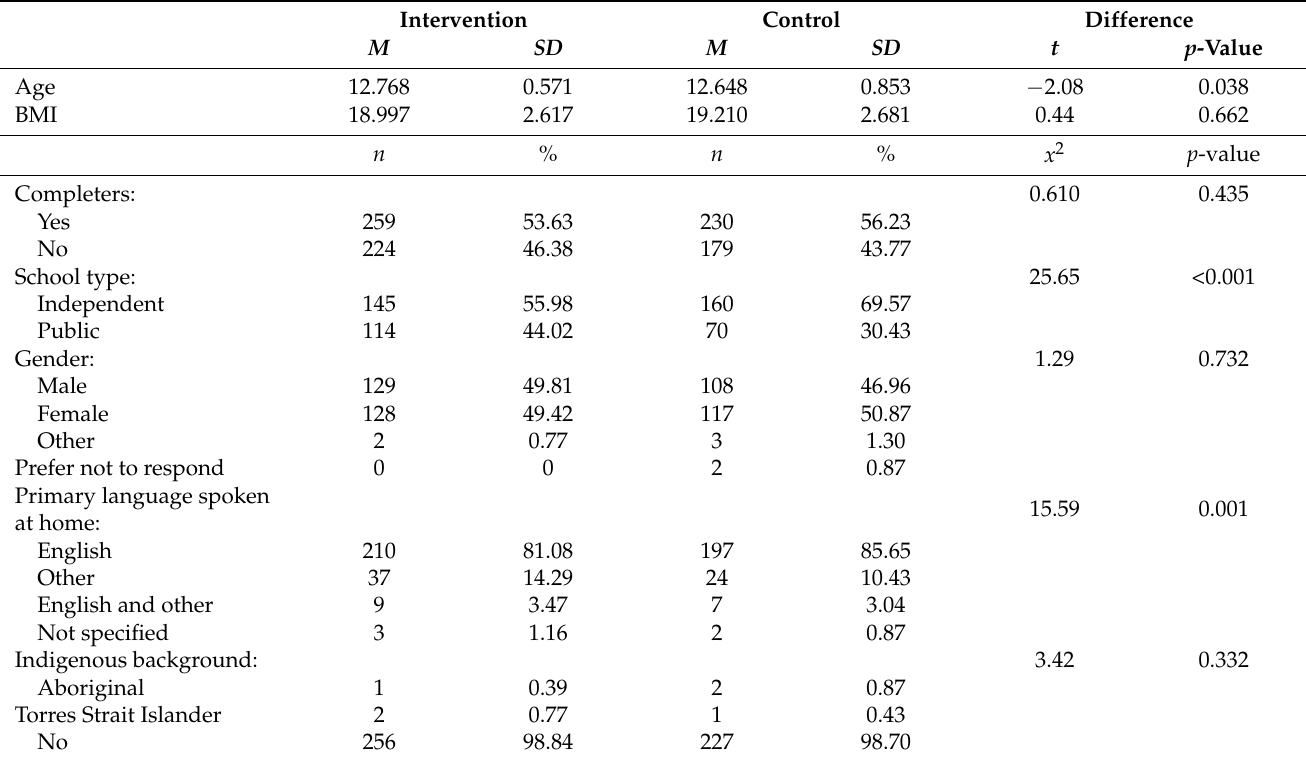
Table 2. Demographic differences at baseline between intervention and control groups.